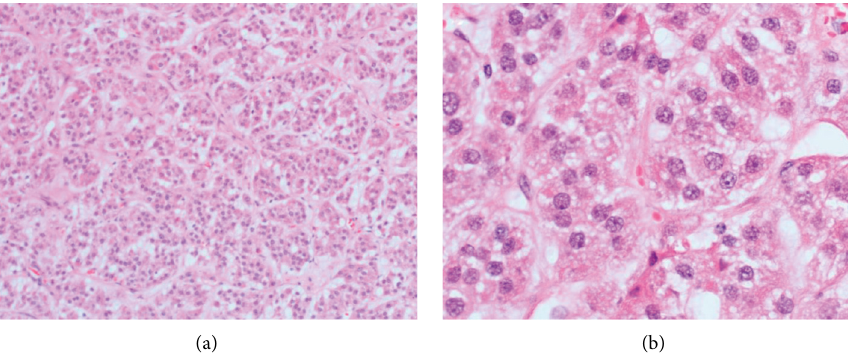
Figure 6: Photomicrograph of left adrenal tumor of Patient B. (a) Tumor cells in trabecular pattern (H&E × 100). (b) Tumor cells demonstrate nuclei of variable size and eosinophilic granular cytoplasm (H&E ×